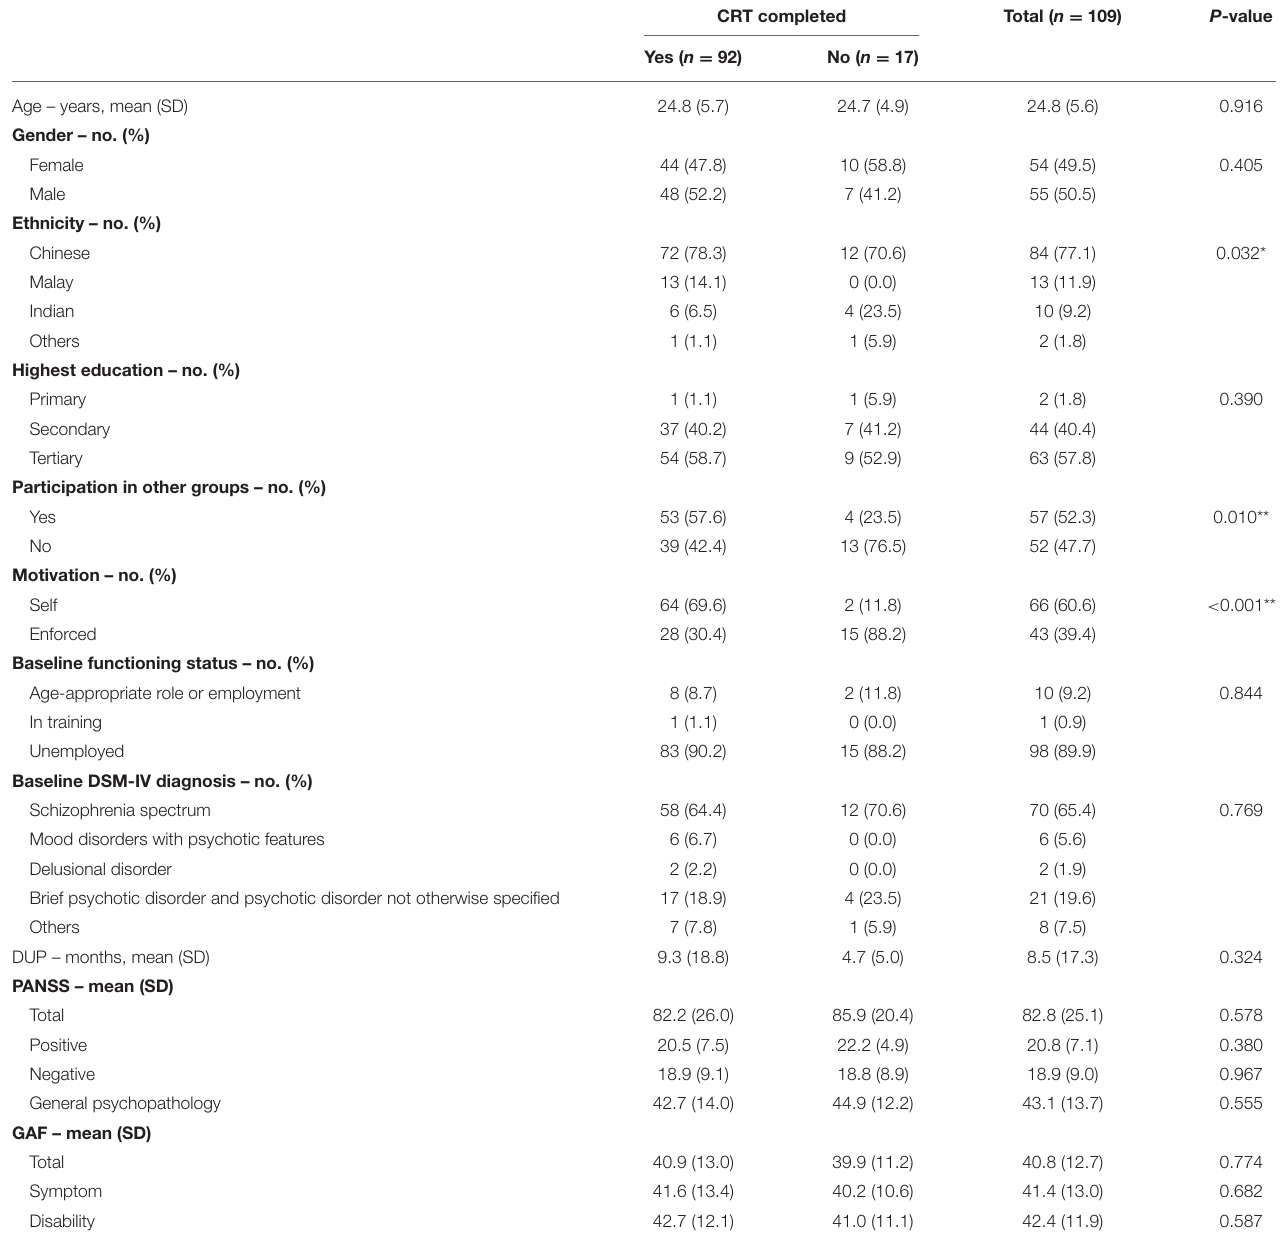
TABLE 1 | Baseline sociodemographic and clinical characteristics of patients who participated in